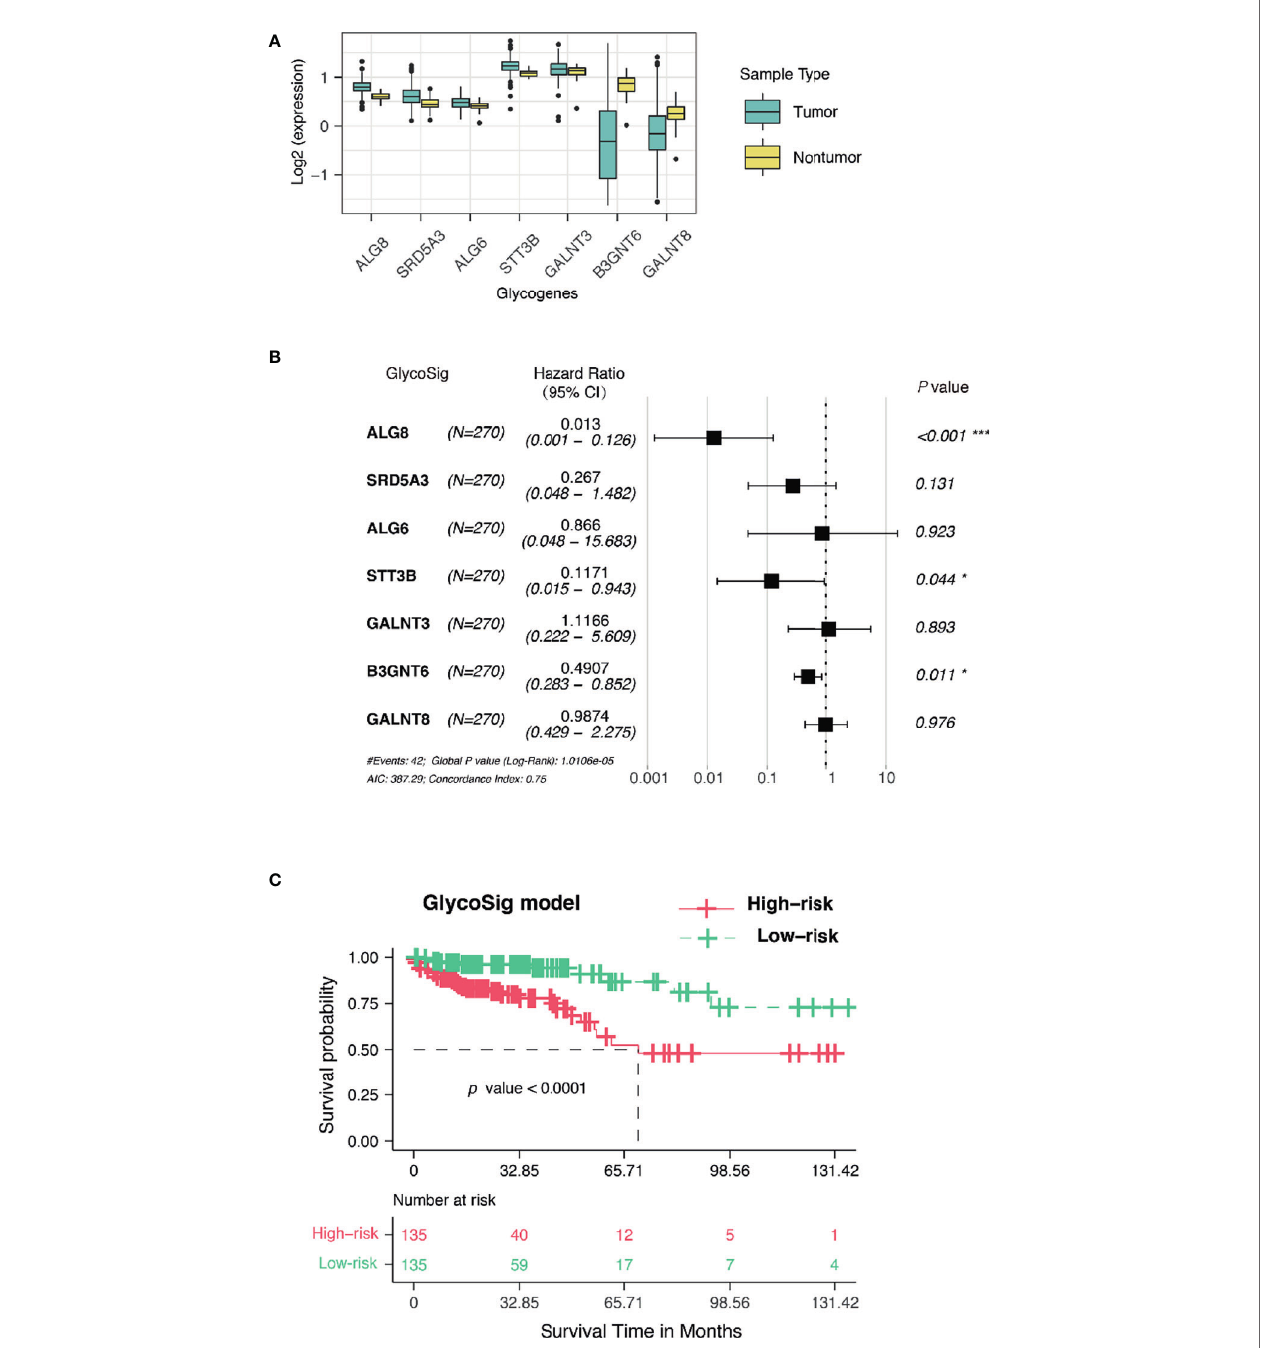
FIGURE 3 | GlycoSig model for the prognosis of pro fi cient mismatch repair (pMMR) colorectal adenocarcinoma (CRAC) in The Cancer Genome Atlas (TCGA) dataset. (A) The expression of seven glycogenes in tumor and non-tumor tissues from TCGA database. (B) Forest plots showed the multivariate Cox regression analysis for GlycoSig; *P < 0.05; ***P < 0.001. (C) Kaplan – Meier survival curves of pMMR CRAC patients classi fi ed into high- and low-risk groups using the